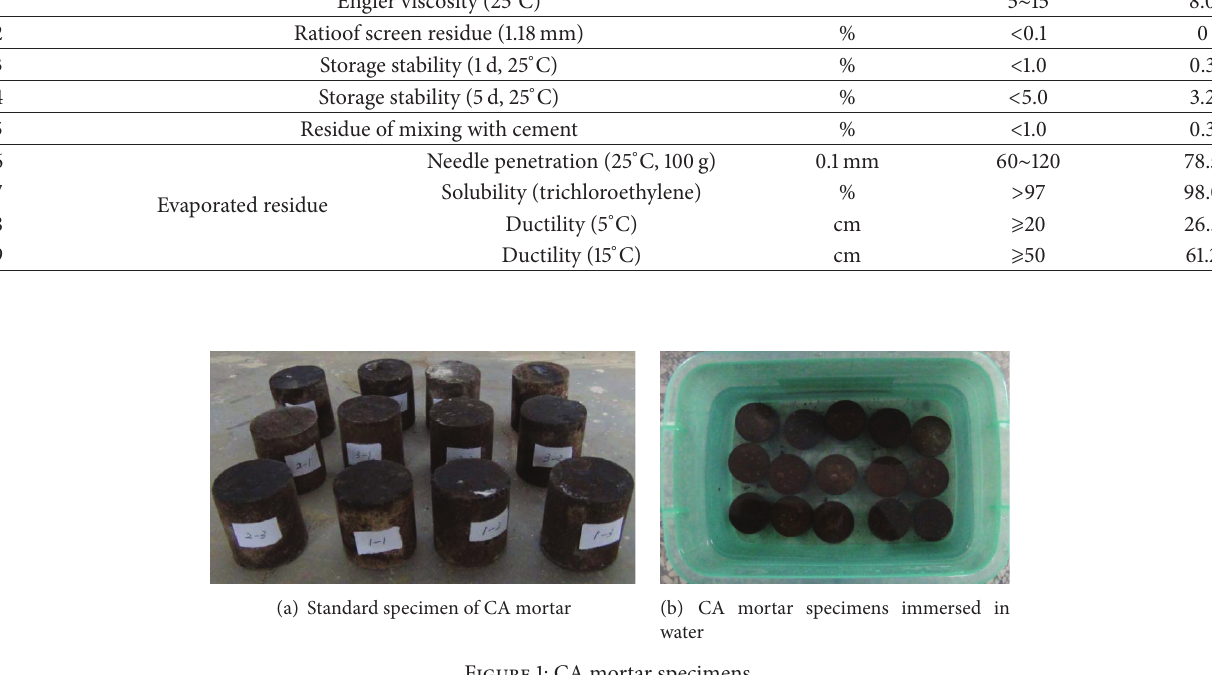
Figure 1: CA mortar